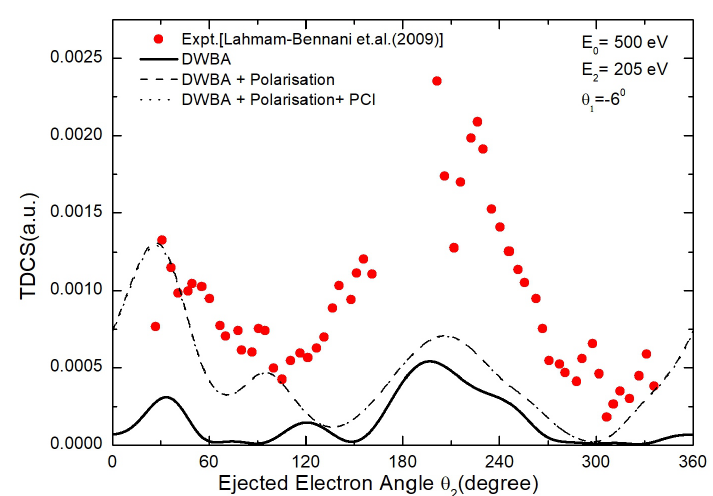
Figure 9. Kinematics is same as Figure 4 and the ejected electron energy chosen is 205